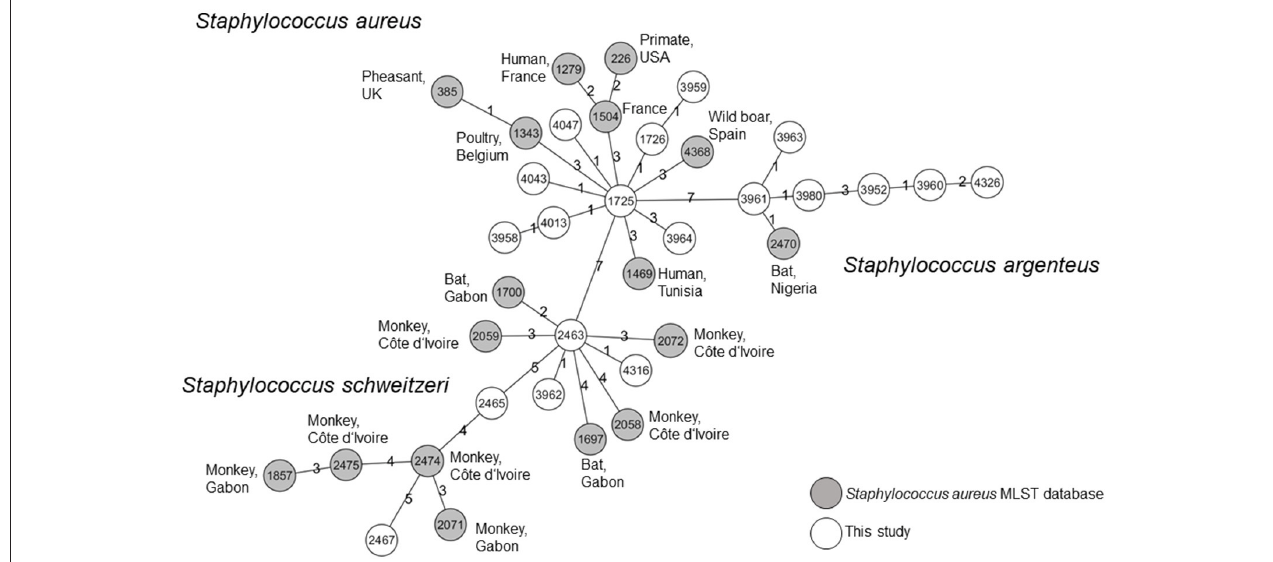
FIGURE 3 | Minimum spanning tree. All isolates form this study and the most closely related STs as published on the Staphylococcus aureus MLST Database website (https://pubmlst.org/saureus/) were used to construct this tree based on the seven housekeeping genes of the MLST scheme. Nodes are labeled with STs. The origin of the isolates is color-coded (white: this study, gray: MLST database). The source (host and country) are indicated for all STs from the MLST database. The distance between the nodes is shown as the number of differing alleles.